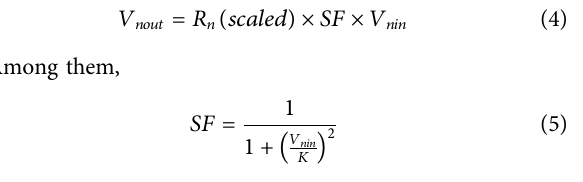
Frontiers in Earth Science |